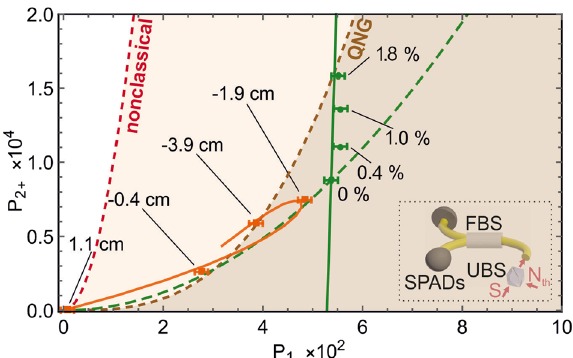
Fig. 3 Measured statistical properties of heralded Stokes light. Observed QNG features are parameterized by photon-number probabilities P 1 and P 2 + of a single and multiphoton events observed in the Stokes mode, respectively. The orange data points show raw photodetection probabilities with the corresponding simulation depicted by the orange solid curve. The region of observability of QNG properties corresponds to the shaded areas with the dashed thresholds given by the Eq. (2). The QNG is unambiguously proved, despite the large sensitivity of their detectability in the presented feasible range of two-photon coupling ef fi ciencies and corresponding Stokes single-photon probabilities P 1 . This sensitivity can be well characterized and quanti fi ed by measurement of a QNG depth, which can be accessed by introduction of an excess thermal noise 23,34 . The resulting thermalization trajectory for the interaction position of the interaction area d = − 1.9 cm is shown as green data points with the excess thermal noise to Stokes signal ratio NSR h,exc = P th,exc / P 1 explicitly indicated. The corresponding theoretical model is derived by considering mixing of the generated QNG state with an ideal thermal light. The red dashed curve shows the evaluation of the dependence of the observed QNG features on bare losses in the Stokes mode. The red dashed curve depicts the threshold on the observability of the nonclassical character of measured photon statistics by conventional estimation of the sub-Poissonian value of α parameter. The photon statistics is accessed by detection arrangement consisting of the balanced fi ber splitter (FBS) with a fi ber-coupled SPAD in each output port shown in the inset. The optional addition of thermal light has been implemented using the unbalanced T:R = 90:10% beamsplitter (UBS). Error bars correspond to a single standard